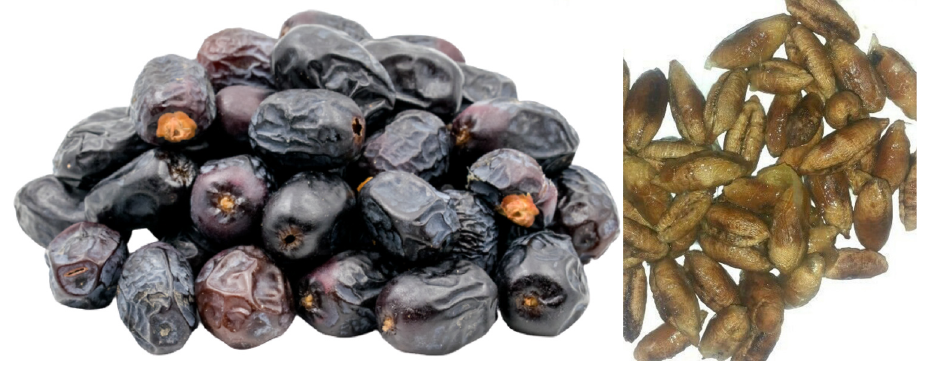
Figure 1. Ajwa dates and their seeds.